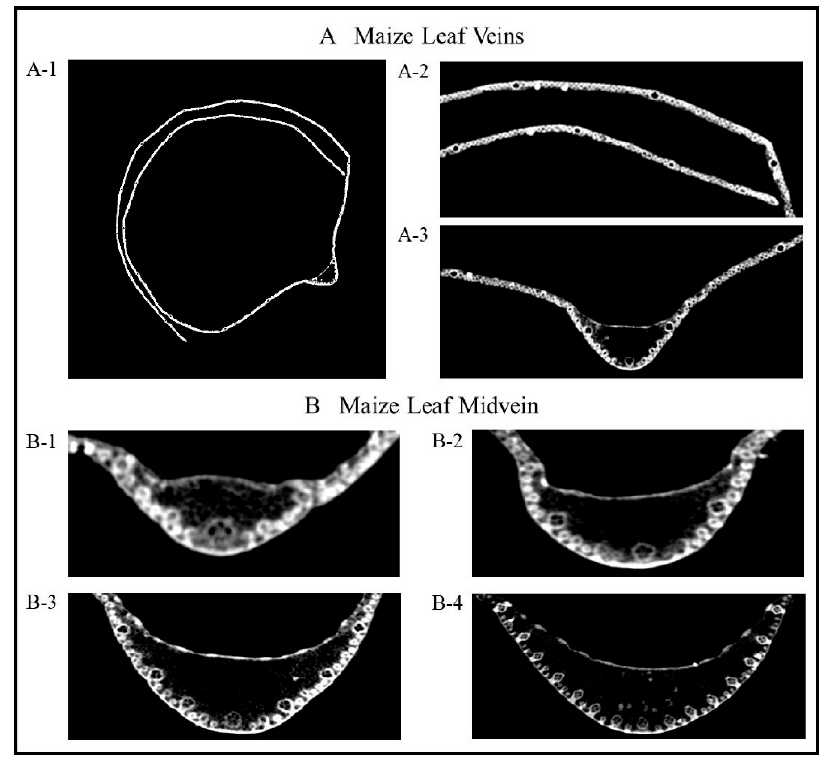
Figure 1. ( A ) Maize ear leaf veins. ( A-1 ) CT image of complete ear leaf cross section of inbred line CIMBL148, ( A-2 ) CT image of lateral veins of CIMBL148, ( A-3 ) CT image of midvein of CIMBL148. ( B ) Maize ear leaf midvein. ( B-1 ) CT image of ear leaf midvein of inbred line CIMBL132, ( B-2 ) CT image of ear leaf midvein of inbred line GEMS11, ( B-3 ) CT image of ear leaf midvein of inbred line GEMS23, ( B-4 ) CT image of ear leaf midvein of inbred line GEMS52.